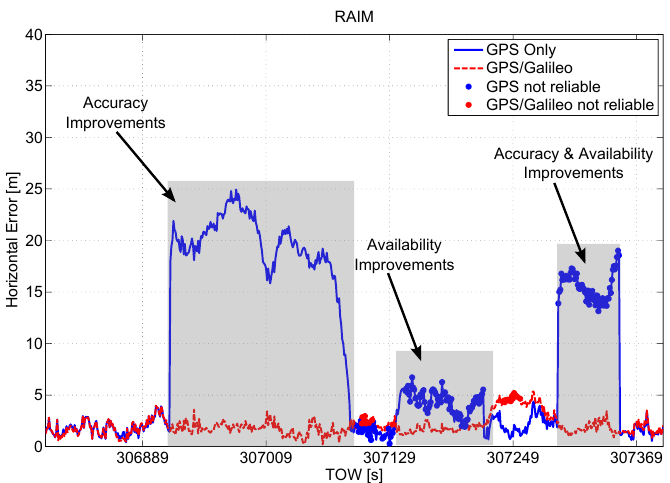
Figure 9. Horizontal error as a function of time. A short time interval of the test is considered to investigate the performance of the configurations with RAIM application.